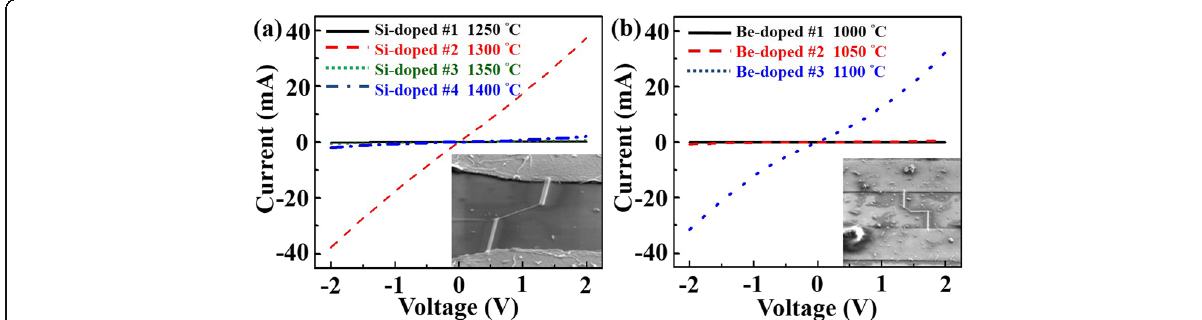
Fig. 5 Current-voltage measurements of SI-doped and Be-doped nanowires. a , b Electrical measurements with different dopants concentration Si and Be,